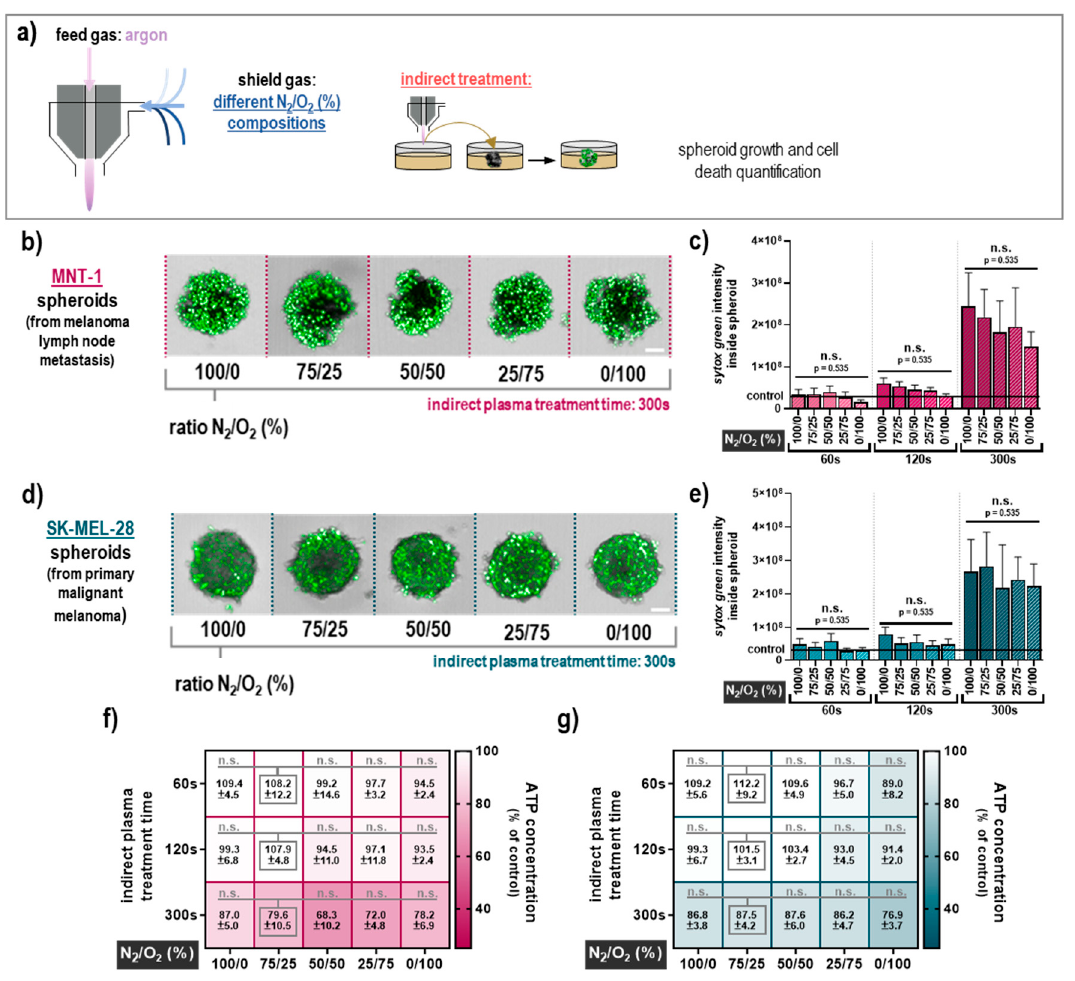
Figure 2. Cytotoxicity of indirect plasma treatment under di ff erent shield gas conditions. ( a ) Schematic presentation of the treatment setup with the plasma jet operated with argon and the shielding device filled with di ff erent N 2 / O 2 compositions (ratios were 100 / 0, 75 / 25, 50 / 50, 25 / 75, and 0 / 100); ( b ) representative images of sytox green staining for all tested gas compositions after incubation in plasma-treated cell culture medium (300 s) for MNT-1 cells; ( c ) quantitative image analyses of sytox green intensity inside the MNT-1 spheroids; ( d ) representative images of sytox green staining for all tested gas compositions after incubation in plasma-treated cell culture medium (300 s) for SK-MEL-28 cells; ( e ) quantitative image analyses of sytox green intensity inside the SK-Mel-28 spheroids; ( f , g ) heat map for normalized ATP concentration (percent of controls) for all tested treatment conditions in MNT-1 ( f ) and SK-MEL-28 ( g ) spheroids. Data are mean + S.E. of three independent experiments with three replicates each. Statistical analysis was performed using two-way analysis of variances comparing the e ff ects of each treatment time and feed gas composition with Dunnett posthoc testing against the respective 75 / 25 (N 2 / O 2 ) feed gas composition as a surrogate for ambient air. Scale bar = 100 µ M; n.s. = not significant.